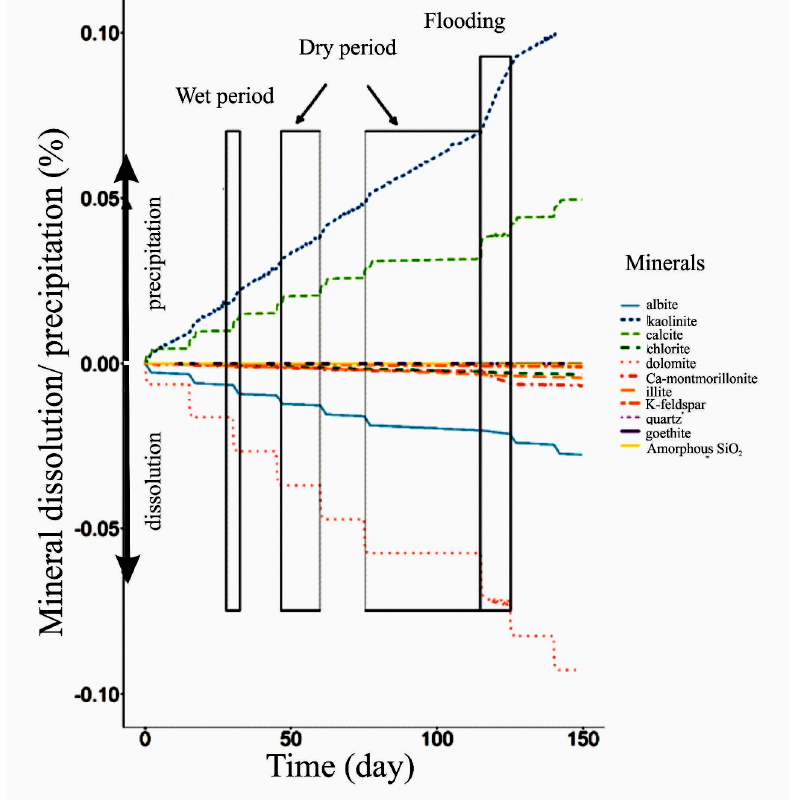
Figure 6. Results of geochemical models, where precipitation and dissolution of the loess mineral composition are shown. The intensity of mineral dissolution or precipitation is di ff erent in the di ff erent weather conditions (dry, wet, or fl ooding period).